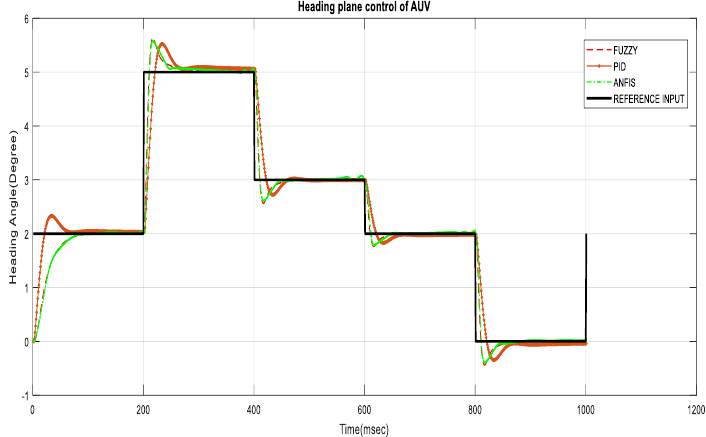
Figure 21. Multi - step response of heading plane control.